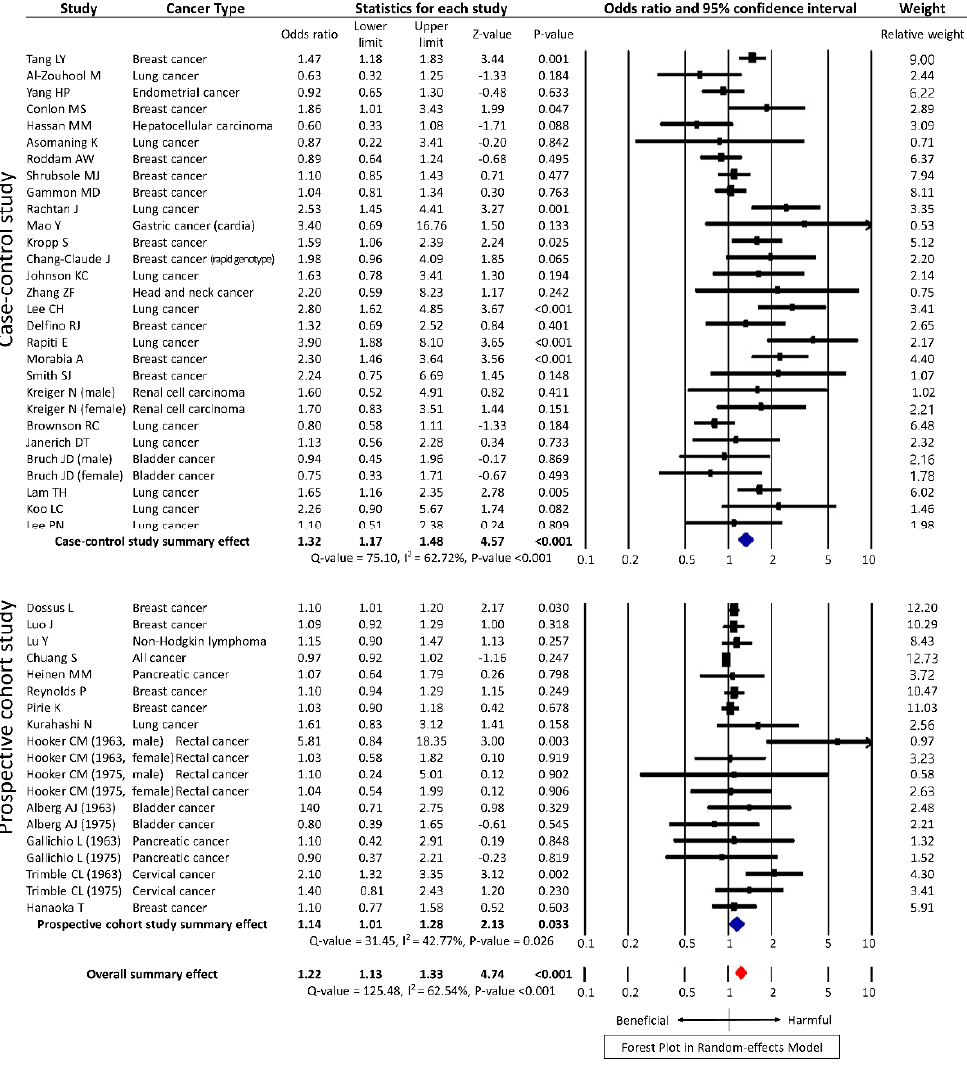
Figure 3. Forest plot on the association of secondhand smoke and cancer risk with fully adjusted data in random-effects model.